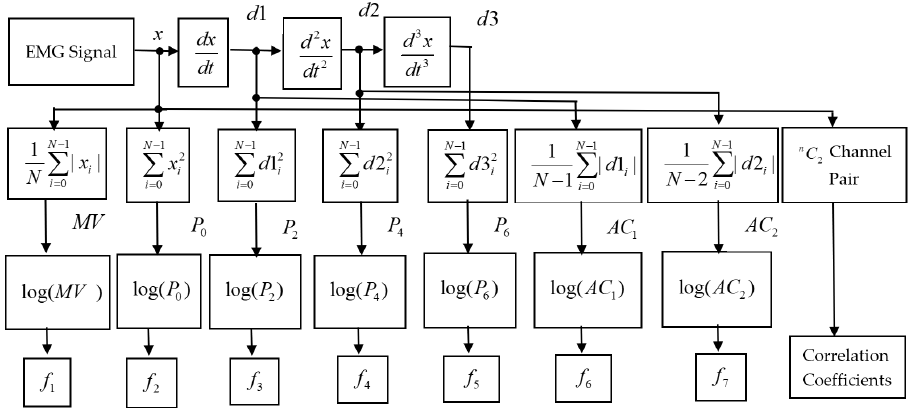
Figure 1. The block diagram of the proposed feature extraction procedure.